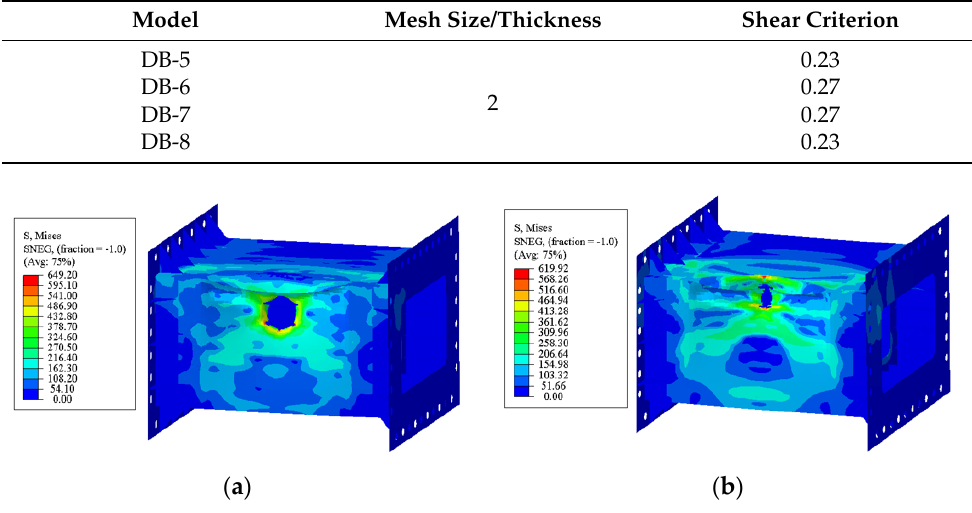
Table 7. The shear criteria for the fracture damage.